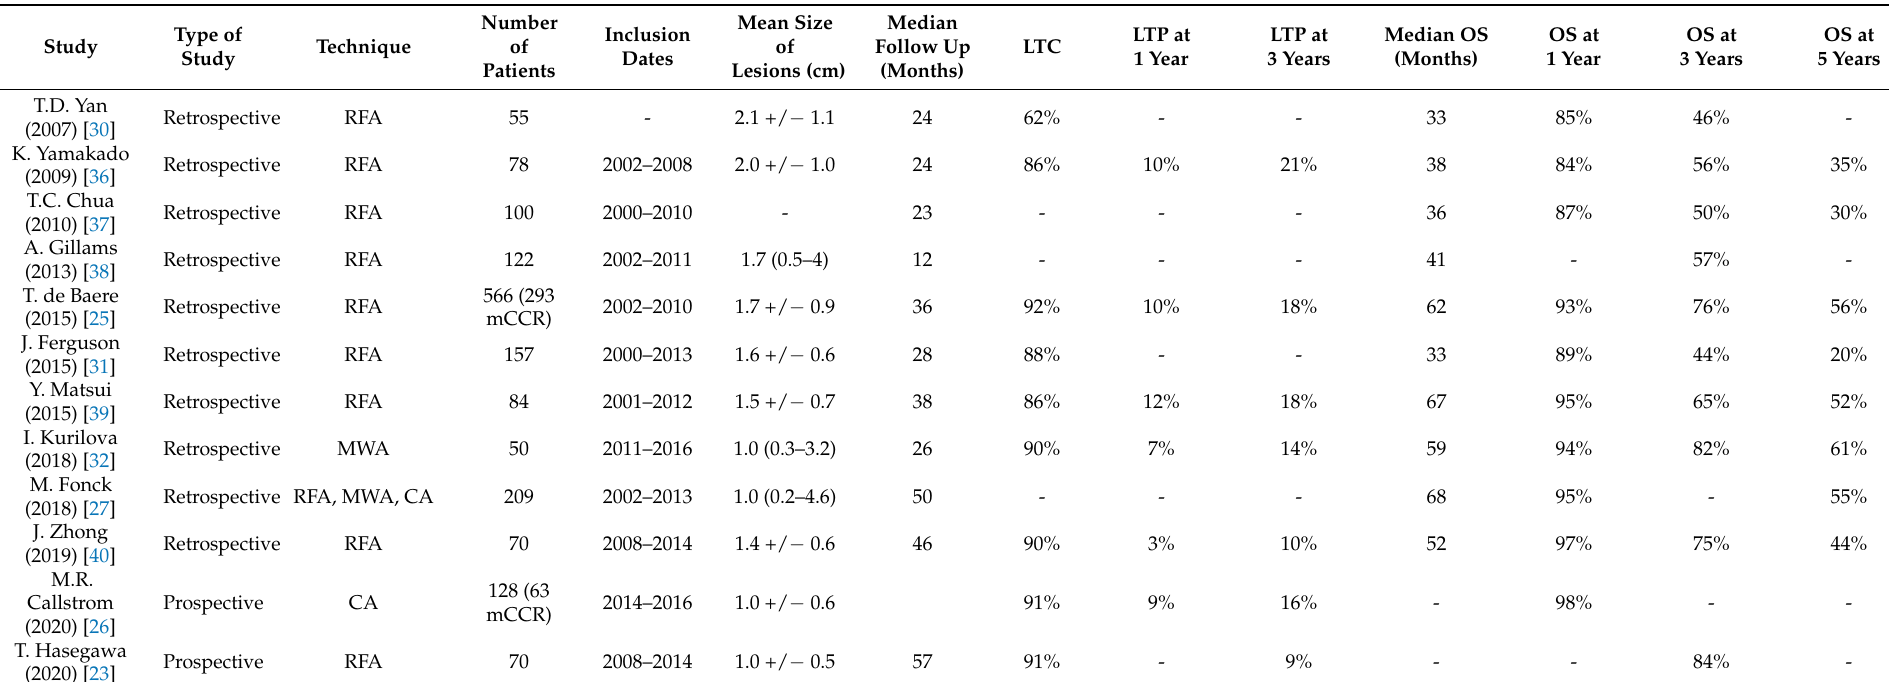
Table 1. Results from 12 relevant original studies involving more than 50 patients treated with thermal ablation in the management of pulmonary metastases of colorectal cancer, with a minimal follow-up of 12